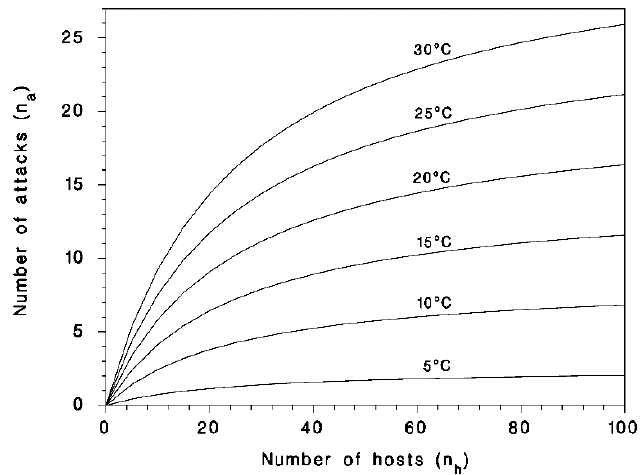
Figure 3. The temperature-dependent functional response of Tranosema rostrale ( n a : Number of attacks generated per day per female parasitoid) on larvae of eastern spruce budworm (SBW) or OBL ( n h : Number of hosts). Equations (1) and (2).